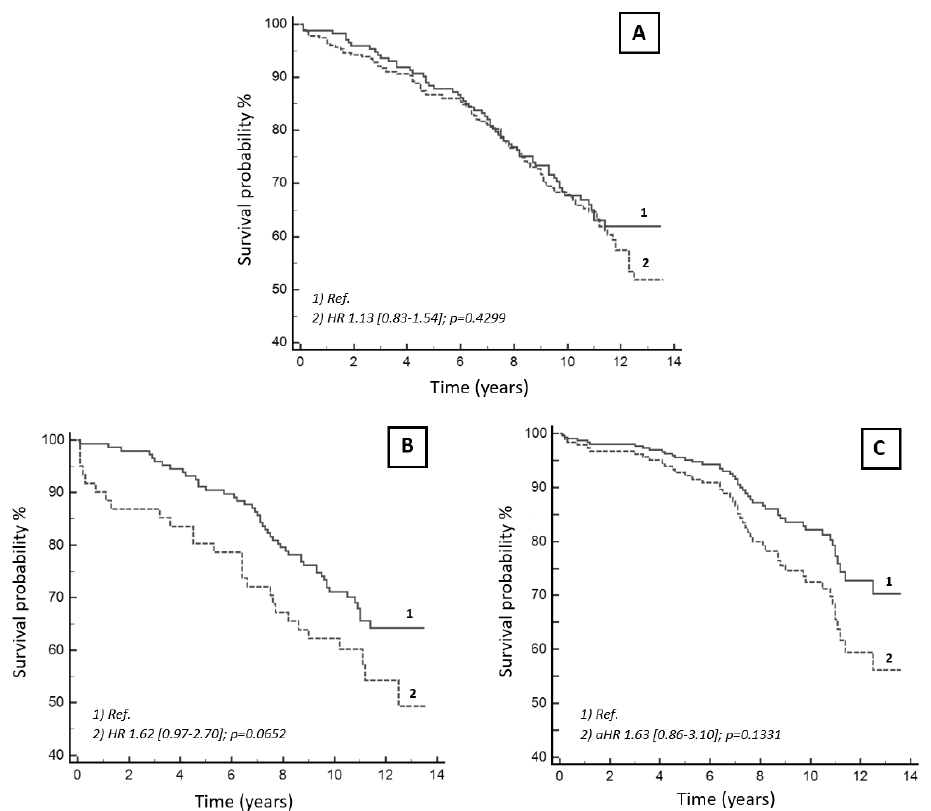
Figure 3. Long-term survival in patients with new-onset post-surgical atrial fibrillation on/off oral anticoagulation after hospital discharge. ( A ) Unadjusted survival curves in patients with new-onset post-operative atrial fibrillation occurring after all types of cardiac surgery. ( B ) Unadjusted survival Kaplan–Meier curves in patients who underwent coronary artery bypass surgery only. ( C ) Fully adjusted curves in this latter population. Legend: Not anticoagulated patients with new-onset post-operative atrial fibrillation (1) and anticoagulated patients (2). Comparisons between the two subgroups are reported as hazard ratios (HR) and related 95% confidence intervals [squared brackets], and p -values as assessed in both univariable and multivariable analyses. See text for details.